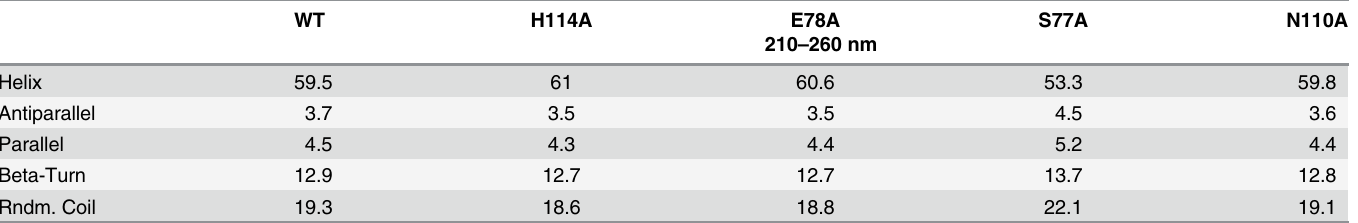
Table 1. Structural contents of TtgR WT and mutants (%), in the absence of effectors. Data were obtained by deconvolution of the far UV CD spectra at 30°C.